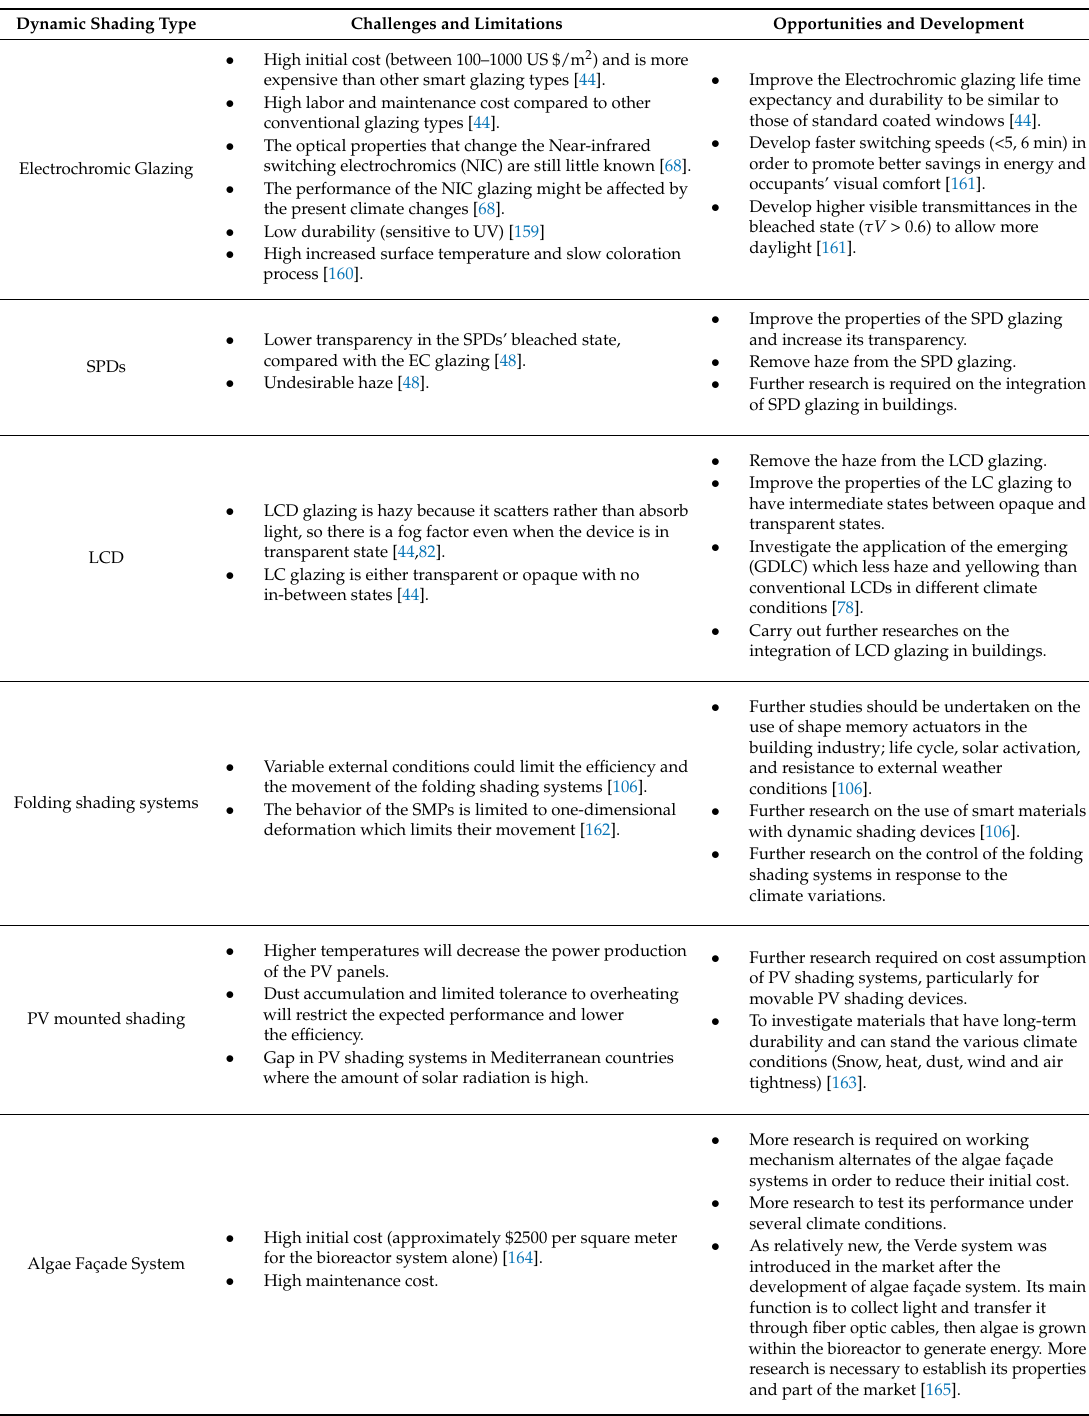
Table 7. Challenges and future developments of dynamic shading